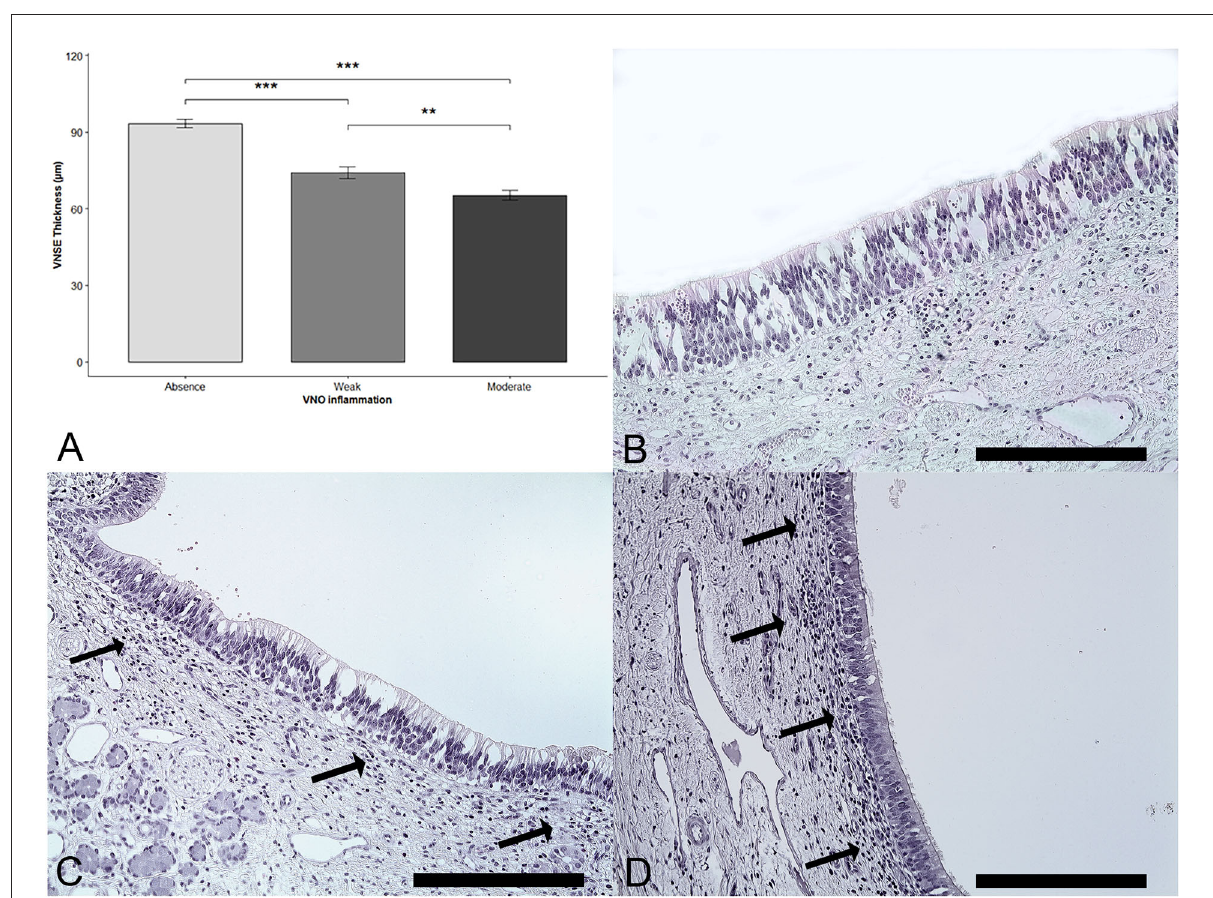
FIGURE2 Vomeronasal sensory epithelium (VNSE) thickness decreases with inflammation intensity. Hematoxylin and eosin (H&E) staining was used to measure the thickness. (A) VNSE thickness according to the vomeronasal organ inflammation. Data are expressed in µ m and shown as the mean ± SD (*** = p < 0.001; **: p < 0.01). (B) Healthy epithelium, score = 0, (C) Weak inflammation, score = 1: few lymphocytes were found under the epithelium (black arrows). (D) Moderate inflammation, score = 2: denser inflammatory infiltrate mainly composed of lymphocytes was found above the VNSE (black arrows). (Objective x20, Scale bars 200 µ